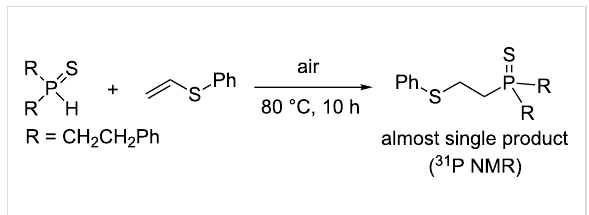
(congeners of vinyl sulfides) were found to react with phosphi- ne oxide 1a at 80 °C for about 30 and 20 h, respectively, to deliver difficult-to-separate mixtures of organophosphorus com- pounds ( 31 P